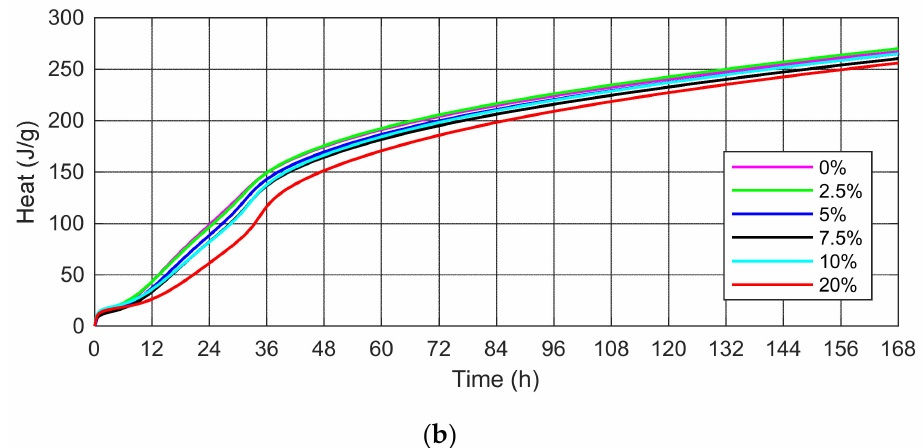
Figure 5. The total heat evolved for cement mortars (Q(t)) without and with 2.5%, 5%, 7.5%, 10% and